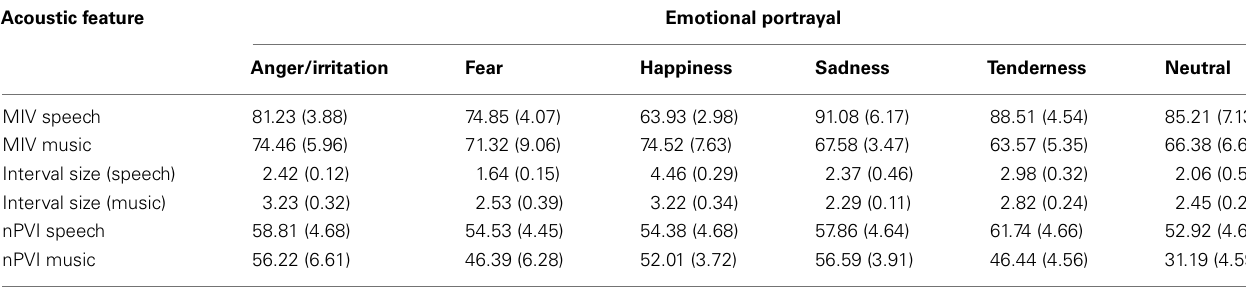
Table 3 |The means for each of the six emotions and acoustic features (standard errors are in